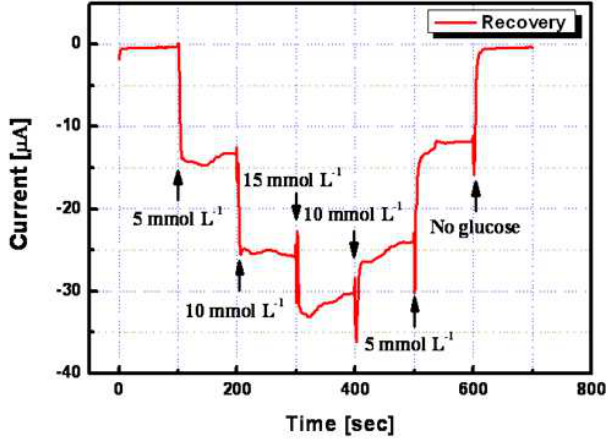
Figure 10. Current–time recordings for recovery characteristic of optimized non-enzymatic glucose micro-sensor in step change of glucose